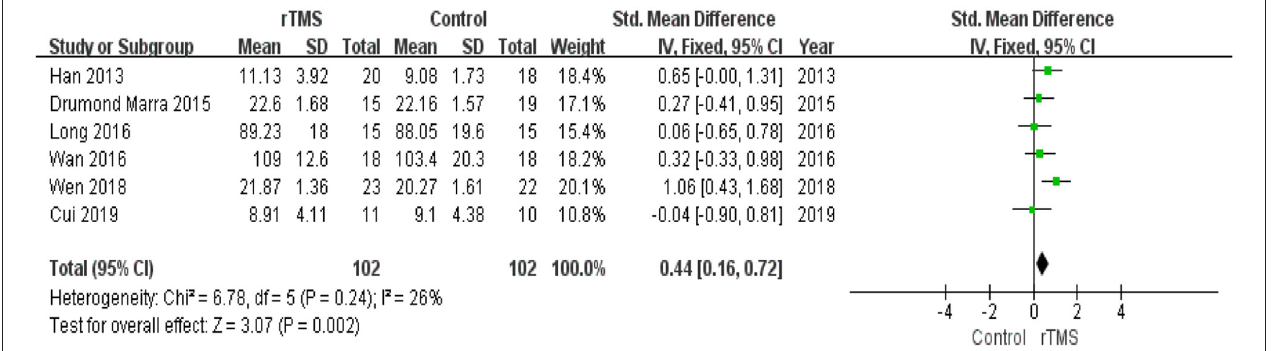
FIGURE 7 | Forest plot of the comparison between the repetitive transcranial magnetic stimulation and control groups with respect to memory.